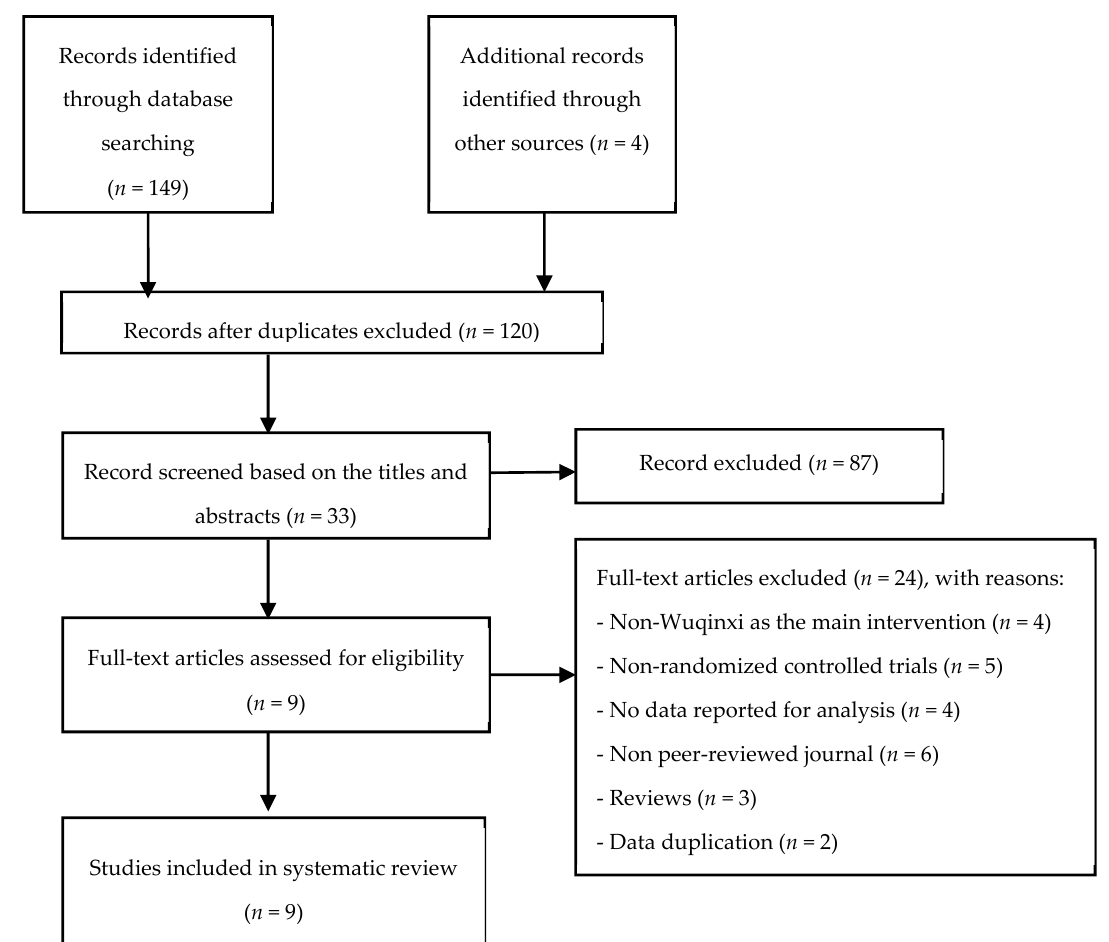
Figure 1. Flowchart displaying study selection.